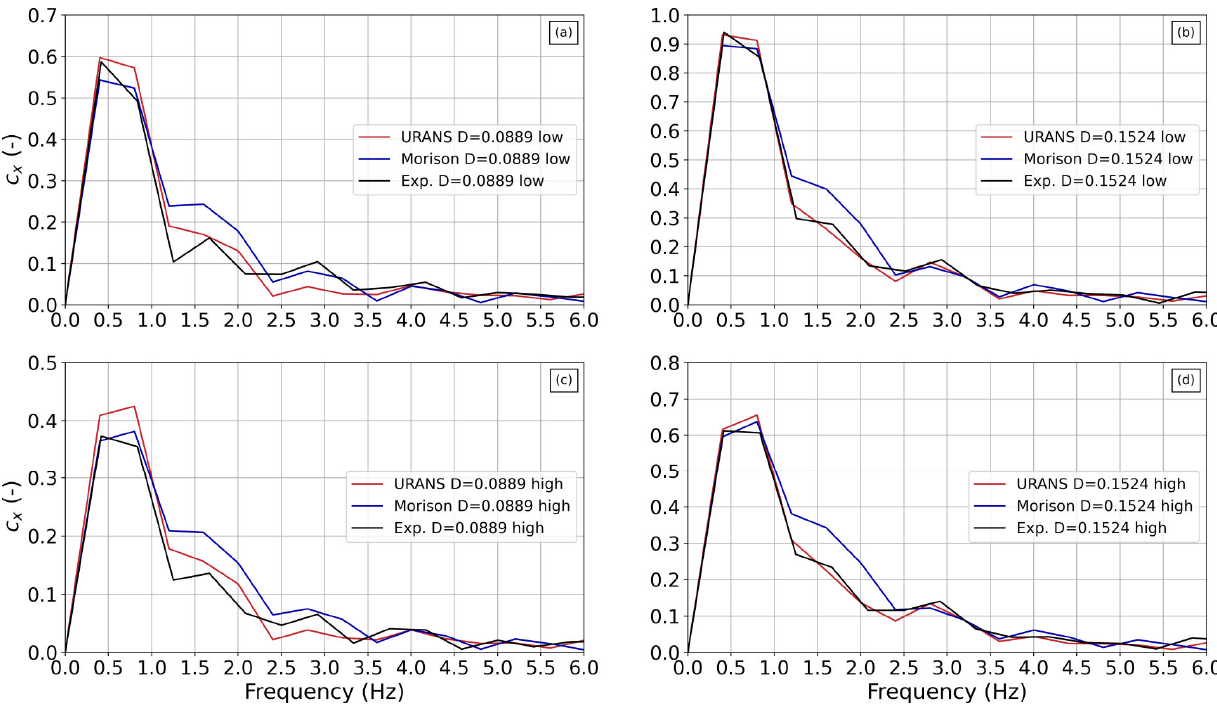
Figure 15. Frequency spectra of load coefficient c x in scenario 1 for the small-diameter cylinder in its low position ( a ), for the large-diameter cylinder in its low position ( b ), for the small-diameter cylinder in its high position ( c ), and for the large-diameter cylinder in its high position ( d ).